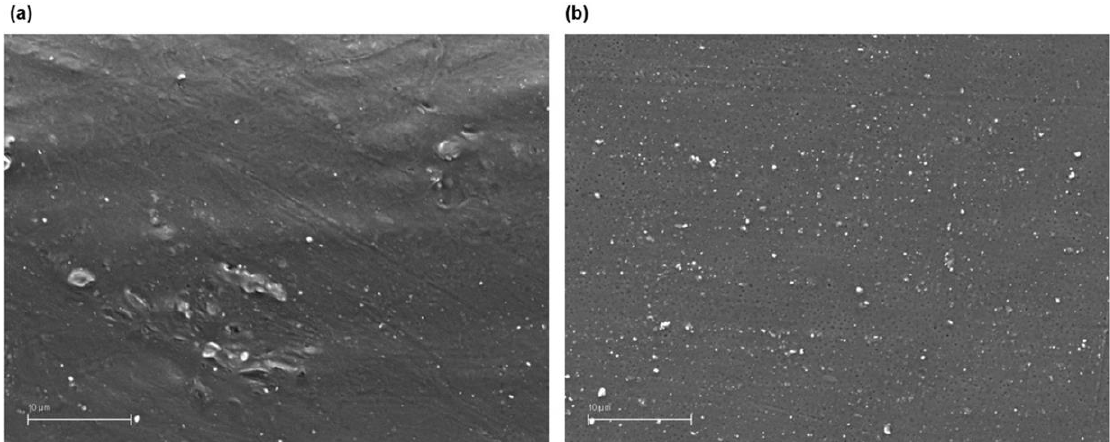
Figure 7. Polycarbonate component manufactured with 3D FDM printing without chemical treatment 15000 (a) and with dichloromethane chemical treatment 15000 ( b ).